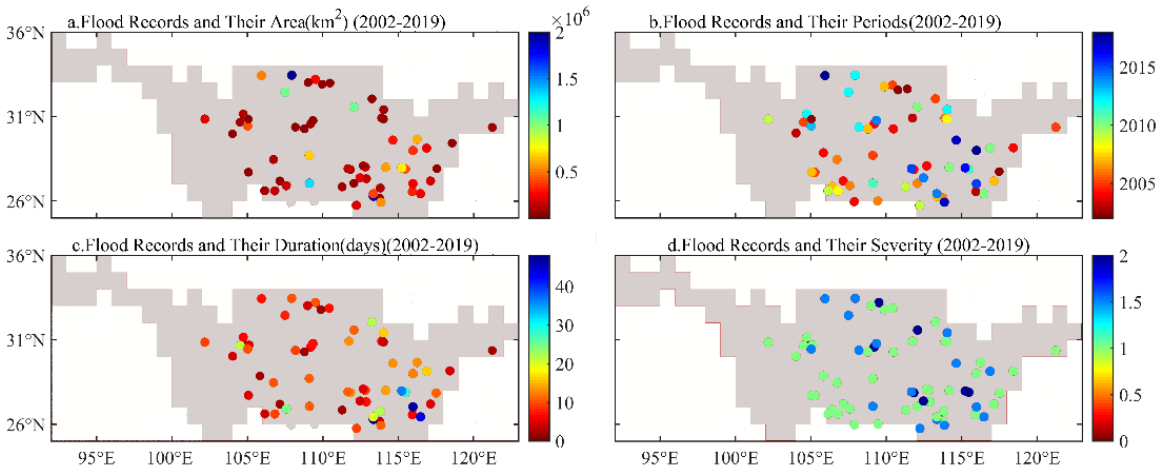
Figure 2. Floods records and their characteristics in the YRB during April 2002–December 2019. ( a – d ) are the area (km 2 ) affected by floods, the year of flood disaster, the duration (days) of each flood disaster, and the severity classification of each flood disaster, respectively. The color dots represent the flood locations in the YRB during April 2002–December 2019.) .